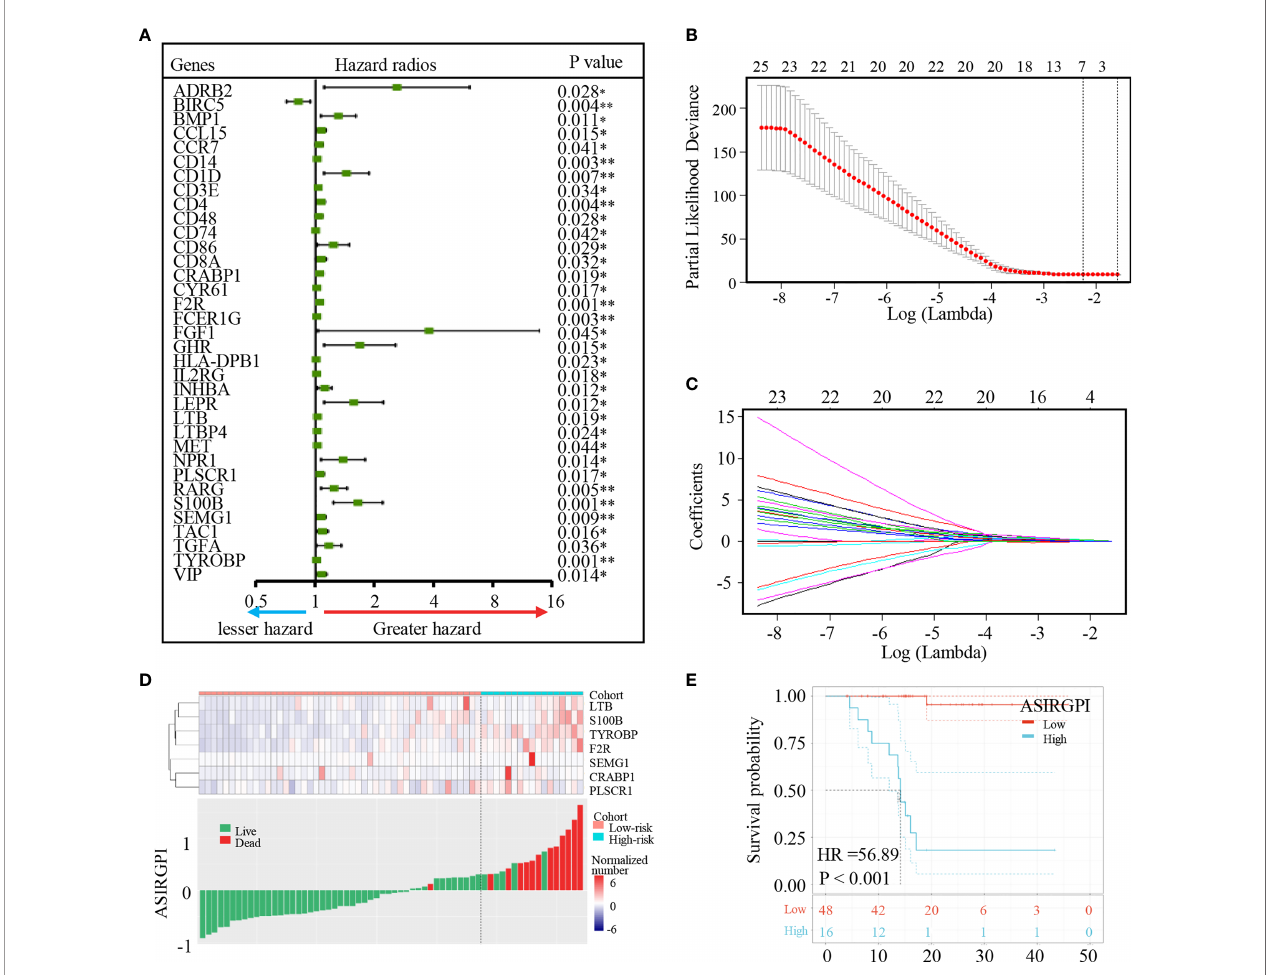
FIGURE 3 | Identi fi cation of Asian-speci fi c survival-associated IRGs and generation of the ASIRGPI in the TCGA-STAD Asian cohort. (A) Forest plot of hazard ratios of prognostically relevant immune genes, revealing a prognostic value in AGC. *P < 0.05, **P < 0.01. (B, C) Least absolute1 shrinkage and selection operator (LASSO) regression was performed, calculating the minimum criteria. (D) Patients were divided into high-risk and low-risk groups with ASIRGPI score = 0.308585 utilized as the cutoff value. The relationships between the expression of seven prognostic genes (upper) and risk score distribution with survival status (bottom) in the TCGA-STAD Asian cohorts. (E) Kaplan – Meier curves for the high (n = 16) and low (n = 48) risk score patient groups in the TCGA-STAD Asian cohort. Log-rank test, p <